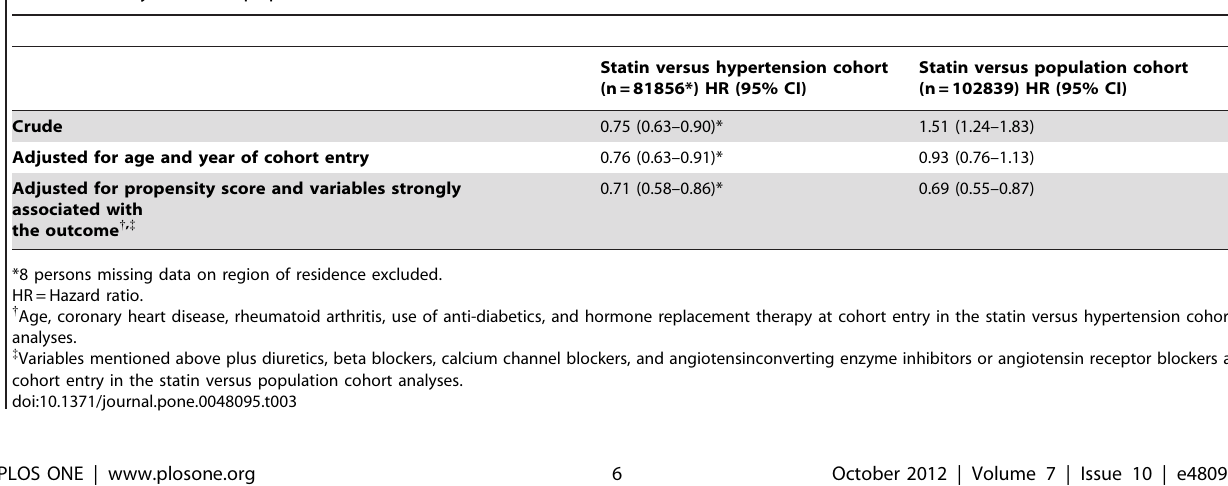
Table 3. Risk of low-energy hip fracture in adherent users of statins compared with adherent users of antihypertensive drugs and with randomly selected population